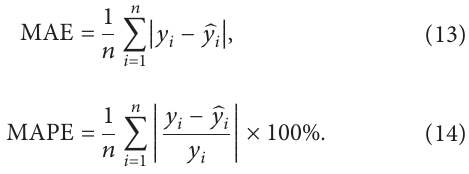
Algorithm 1 firstly preprocesses the wind speed data, normalizes and divides the data to obtain a training set and a